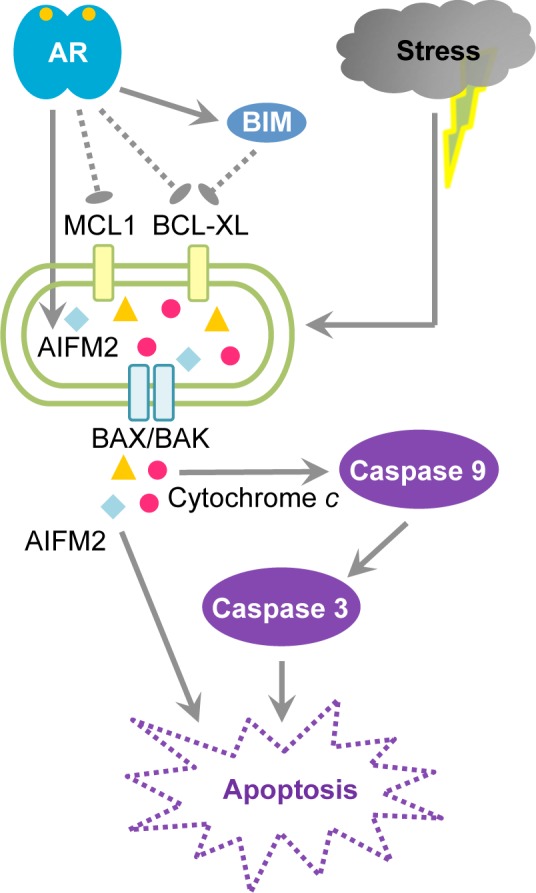
A model for androgen-sensitized apoptosis of HPr-1AR.Activation of AR by agonists, such as DHT, enhances AR nuclear accumulation and transcriptional regulation of target genes, including genes involved in the regulation of apoptosis. We propose that AR exerts pro-apoptotic roles by modestly up-regulating the expression of pro-apoptotic genes (BCL2L11/BIM and AIFM2) and down-regulating the expressions of pro-survival genes (BCL2L1/BCL-XL and MCL1). The modest changes in the expression of the BCL2 family proteins may explain why DHT treatment alone does not induce apoptosis in HPr-1AR cells. However, the multi-target regulation of BCL2 family proteins by AR signaling may sufficiently stress the mitochondria towards a pro-apoptotic state (i.e., leaky outer membrane) and decrease the threshold for other apoptotic stimuli to further enhance permeabilization of the mitochondrial outer membrane above the necessary threshold for initiator and executioner caspase activation (caspase-9 and caspase-3, respectively) and apoptotic disassembly of the cells.